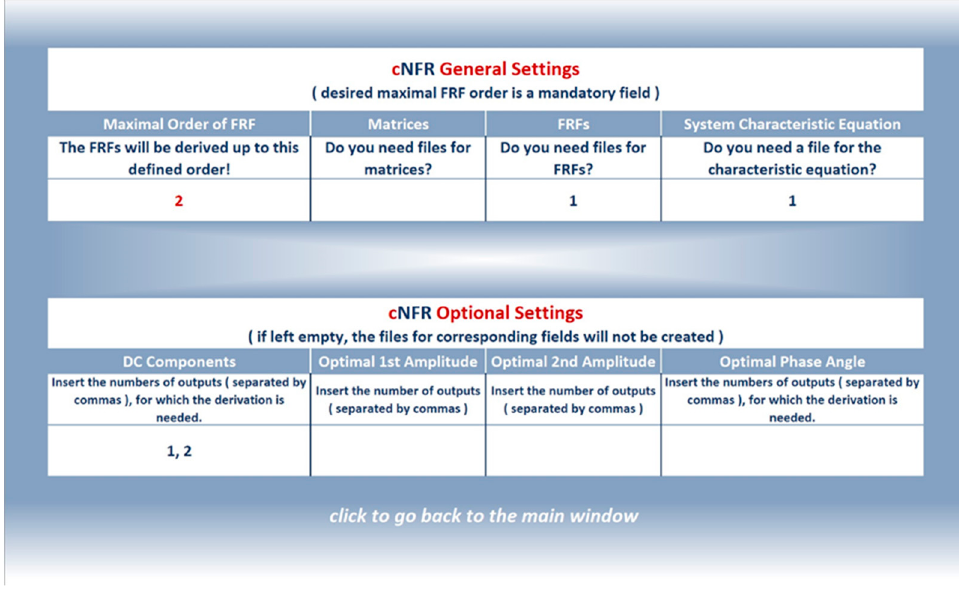
Figure 14. cNFR Settings Window for Example 2: ECR.